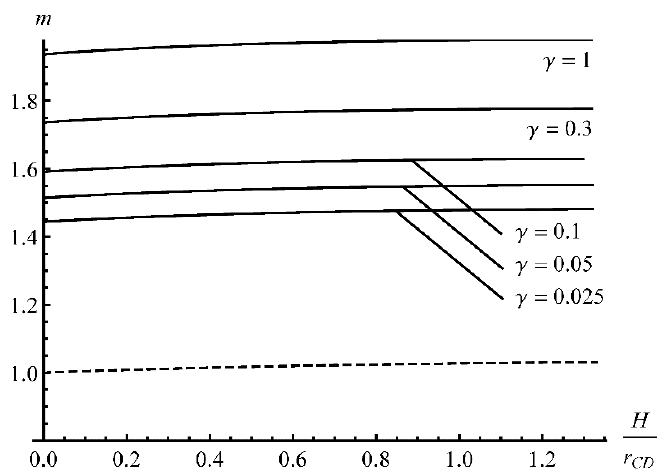
Figure 6. Variation of the dimensionless bending moment as the deformation proceeds at several values of γ . The broken line corresponds to the rate ‐ independent material.